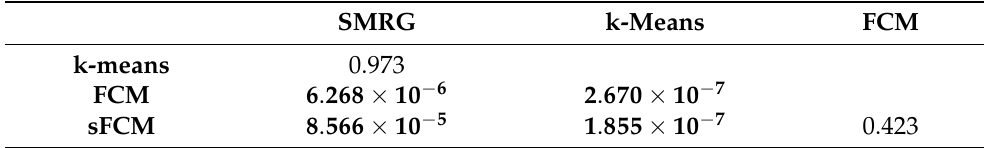
Table 6. p -Values obtained from the statistical validation procedure. The Wilcoxon rank-sum test for pairwise result comparison was used with the alternative hypothesis that the samples do not have equal medians of DI. A significance level of α = 0.05 with the Bonferroni-Holm correction for multiple comparisons was used. Boldface indicates that the null hypothesis can be